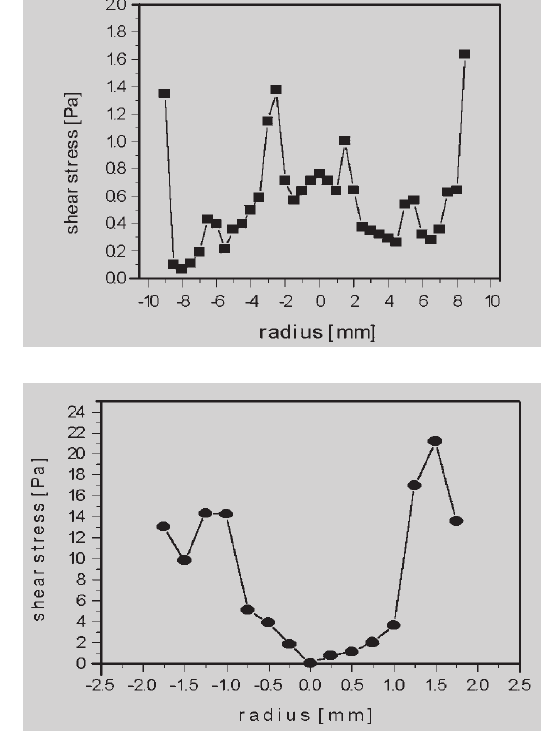
Figure 4: Shear stress pro- files as a function of the glass body radius: a) (left above): crossection A, b) (right above): crossection B, c) (left below): crossection C, d) (right below): crossection D (calculated curves ( Ç ); analytical curves